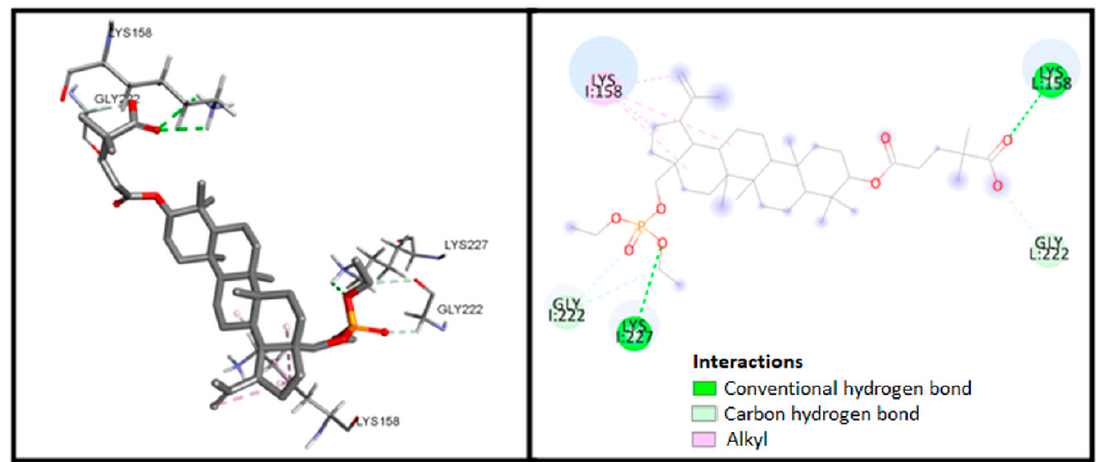
Figure 5. Visualization of interaction between compound 5 and CA-CTD-SP1.